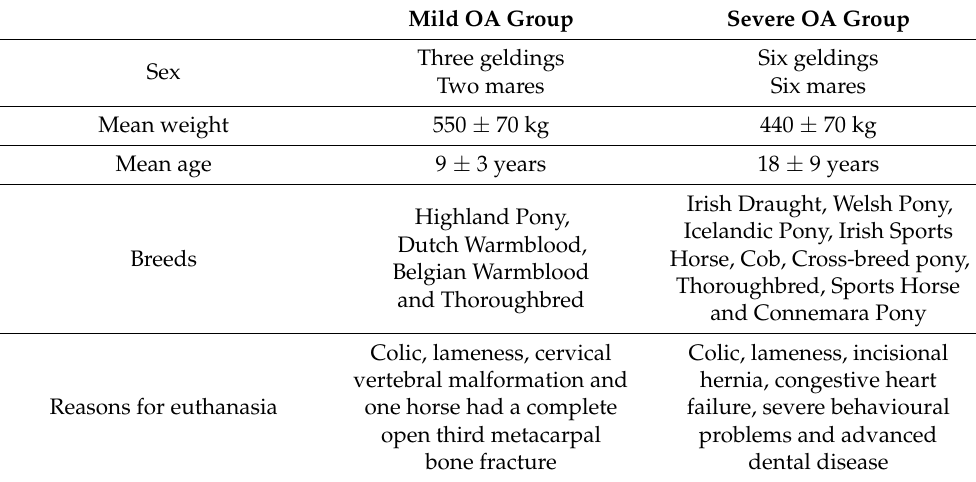
Table 1. Details of the seventeen donor horses used for synovial fluid sample